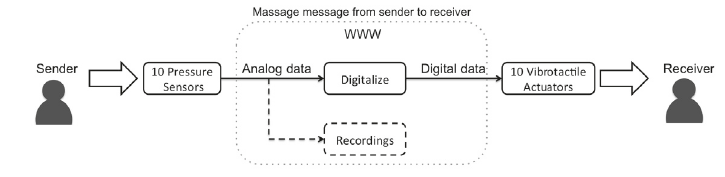
Figure 4: Block diagram of the massage system.